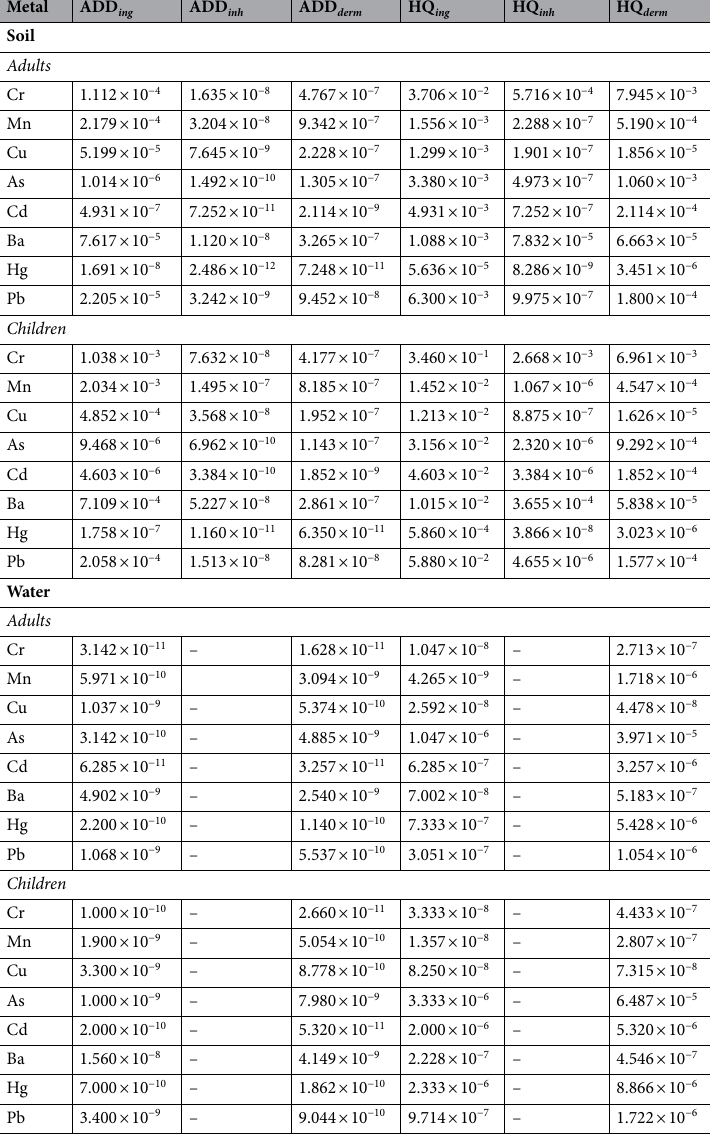
Table 6. Results of ADD and HQ values from soil and water for adults and